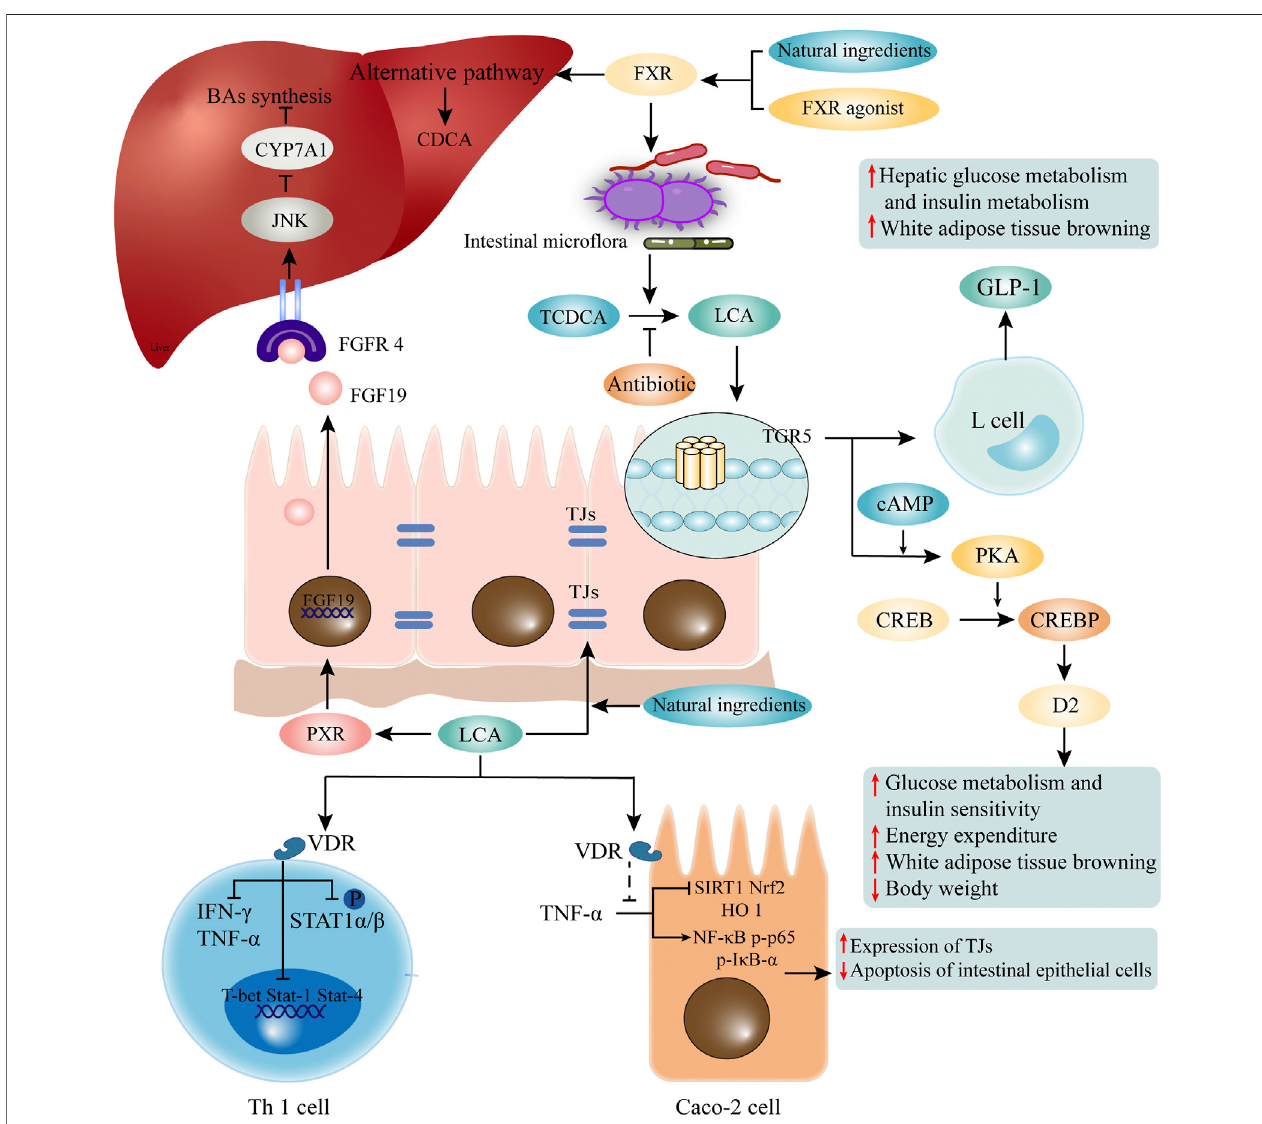
FIGURE 2 | LCA mediated receptors and pathways. LCA mediates its functions through corresponding receptors. LCA activates VDR, and is involved in maintaining the function of TJs of intestinal epithelial cells and inhibition of Th1 cells. Natural ingredients can enhance VDR activation through LCA. Elevated LCA can activate TGR5, which promotes the secretion of GLP1 by intestinal epithelial cells, and participates in glucose metabolism and fat metabolism. The binding of LCA and PXRactivatesthetranscriptionofFGF19.AfterrecognitionofFGFR4onhepatocytes,itinitiatesthec-JunN-terminalkinase(JNK)signalingpathway,whichinhibits CYP7A1andBAsynthesis.Inaddition,activationofFXRinducedbyFXRagonistorsomenaturalingredientsmaychangethecompositionofintestinal fl oraandpromote the production ofLCA. LCA, lithocholic acid; VDR,vitaminD receptor; TJs,tightjunctions; TGR5, Gprotein-coupled receptor fi ve; GLP1, glucagon-like peptide-1;PXR, pregnane X receptor; FGF19, fi broblast growth factor 19; FGFR4, FGF receptor four; CYP7A1, cholesterol 7 α -hydroxylase.